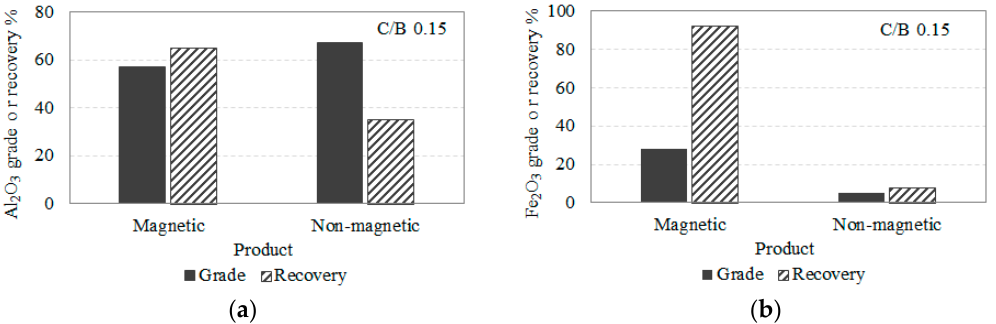
Figure 15. ( a ) Al 2 O 3 grade and recovery and ( b ) Fe 2 O 3 grade and recovery in the magnetic and non-magnetic products obtained after reduction roasting followed by magnetic separation.